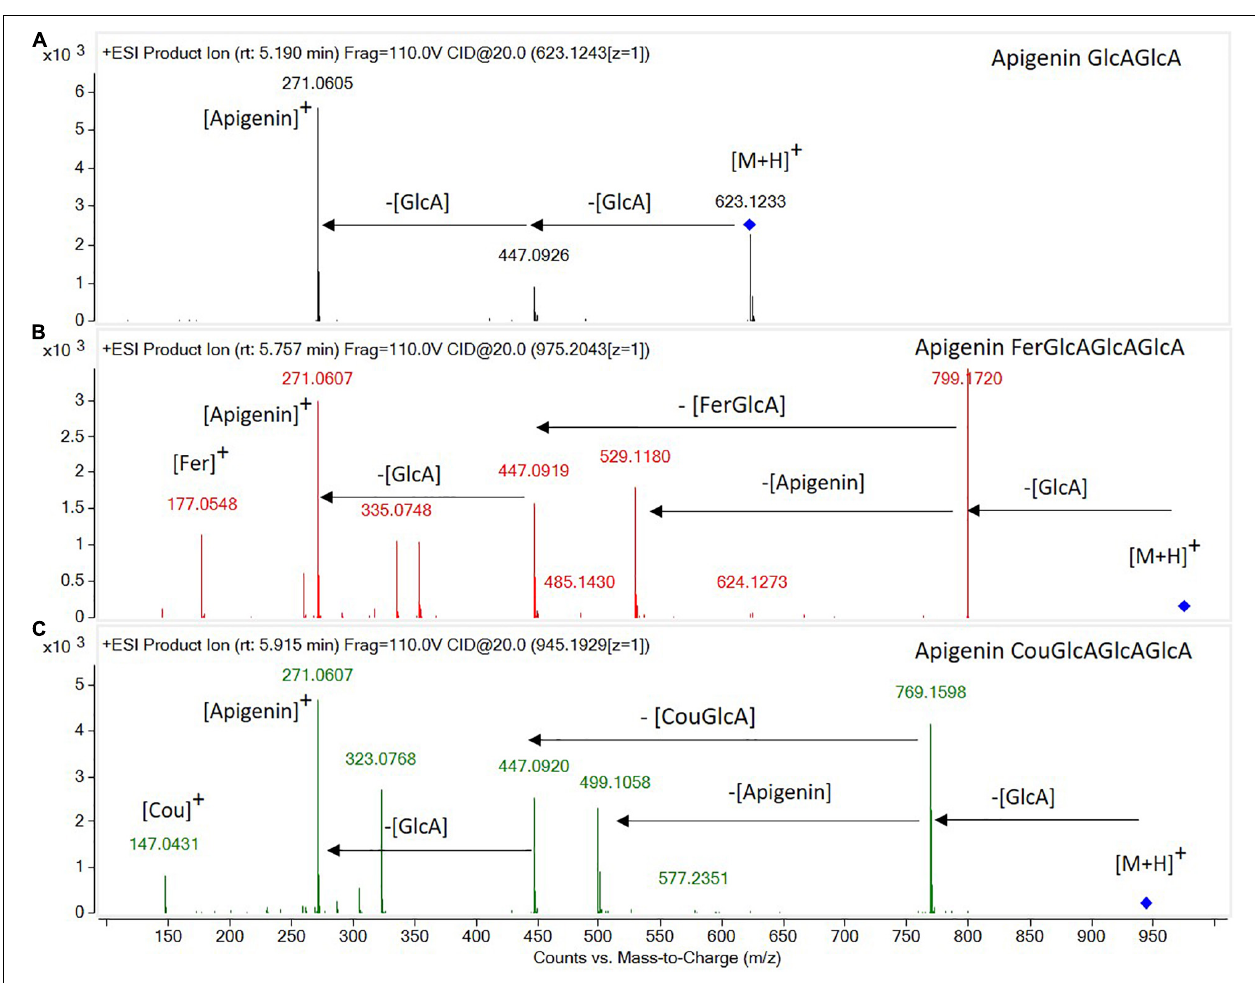
FIGURE 1 | High-resolution tandem mass spectrometry spectra obtained in the ESI(+)-QTOF-MS/MS mode for the identification of flavone glycoconjugates: (A) apigenin diglucuronide, (B) apigenin feruloyl triglucuronide, and (C) apigenin coumaroyl triglucuronide.